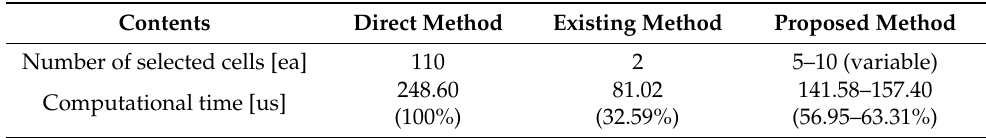
Figure 16. Comparison results of I cha max between the proposed algorithm and the existing method in [21]: ( a ) the estimation results of I cha max ; ( b ) the numerical difference of I cha max between the proposed algorithm and existing method in the time interval of 1100.0–1300.0 s. Table 3. Evaluation results of the computational